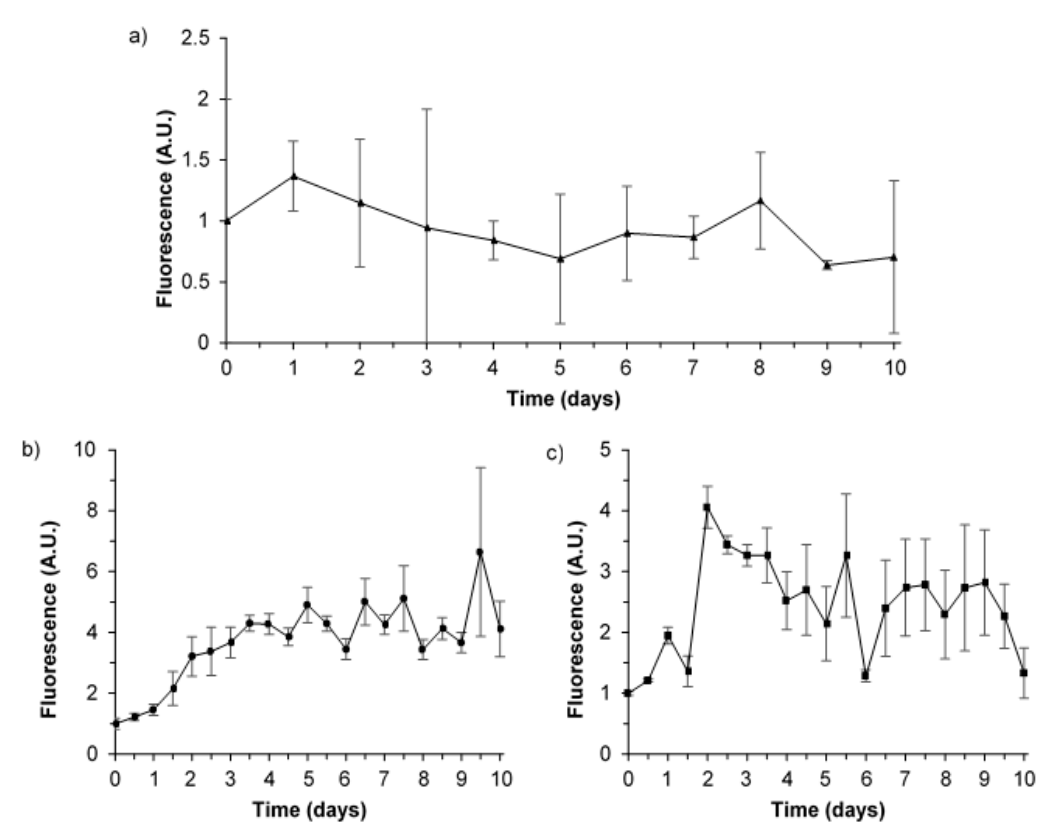
Figure 1. Variation of Peak T fluorescence ( λ ex 280/ λ em 340–360 nm) data throughout the 10-day experimental period. ( a ) averaged environmental water samples ±1 standard deviation ( n = 3), top; ( b ) averaged synthetic water samples ( n = 5), bottom left; and, ( c ) averaged supplemented synthetic water samples ±1 standard deviation ( n = 3), bottom right. See Section 2.2 for sample definitions. All fluorescence data reported as arbitrary units (AU) normalised to time zero and corrected to the water Raman line at λ ex 280/ λ em 310(300–315) nm. Fluorescence excitation ‐ emission matrices (EEM) spectra